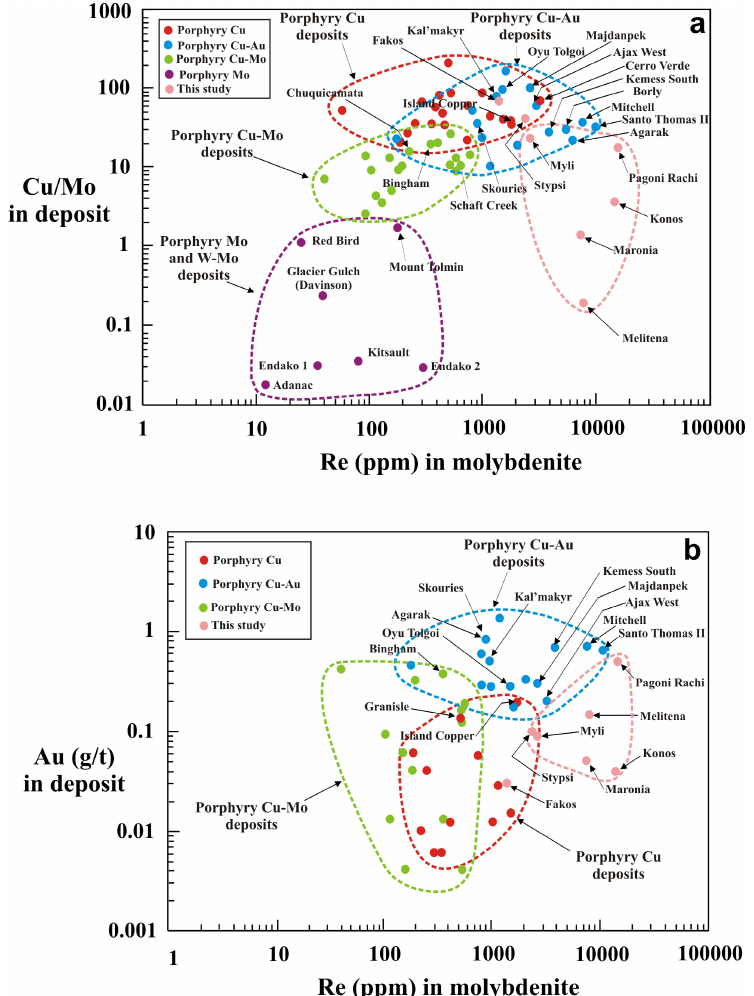
Figure 8. ( a ) Re content of molybdenite vs. Cu/Mo ratio of porphyry deposits; ( b ) Re content of molybdenite vs . gold grades of porphyry deposits (modified after [3]). Re content of molybdenite, Cu/Mo ratio and Au grades of studied prospects are also